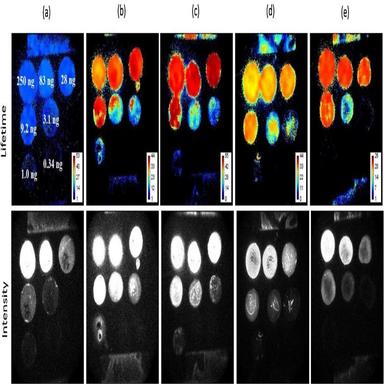
PLIM (top row) and intensity (bottom row) images of the sensor palettes prepared using the cocktails with 1:3 serial dilutions of PtBP dye in: (a) Polystyrene, (b) PVC, (c) PVDC, (d) PMMA and (e) Hydrogel D4.